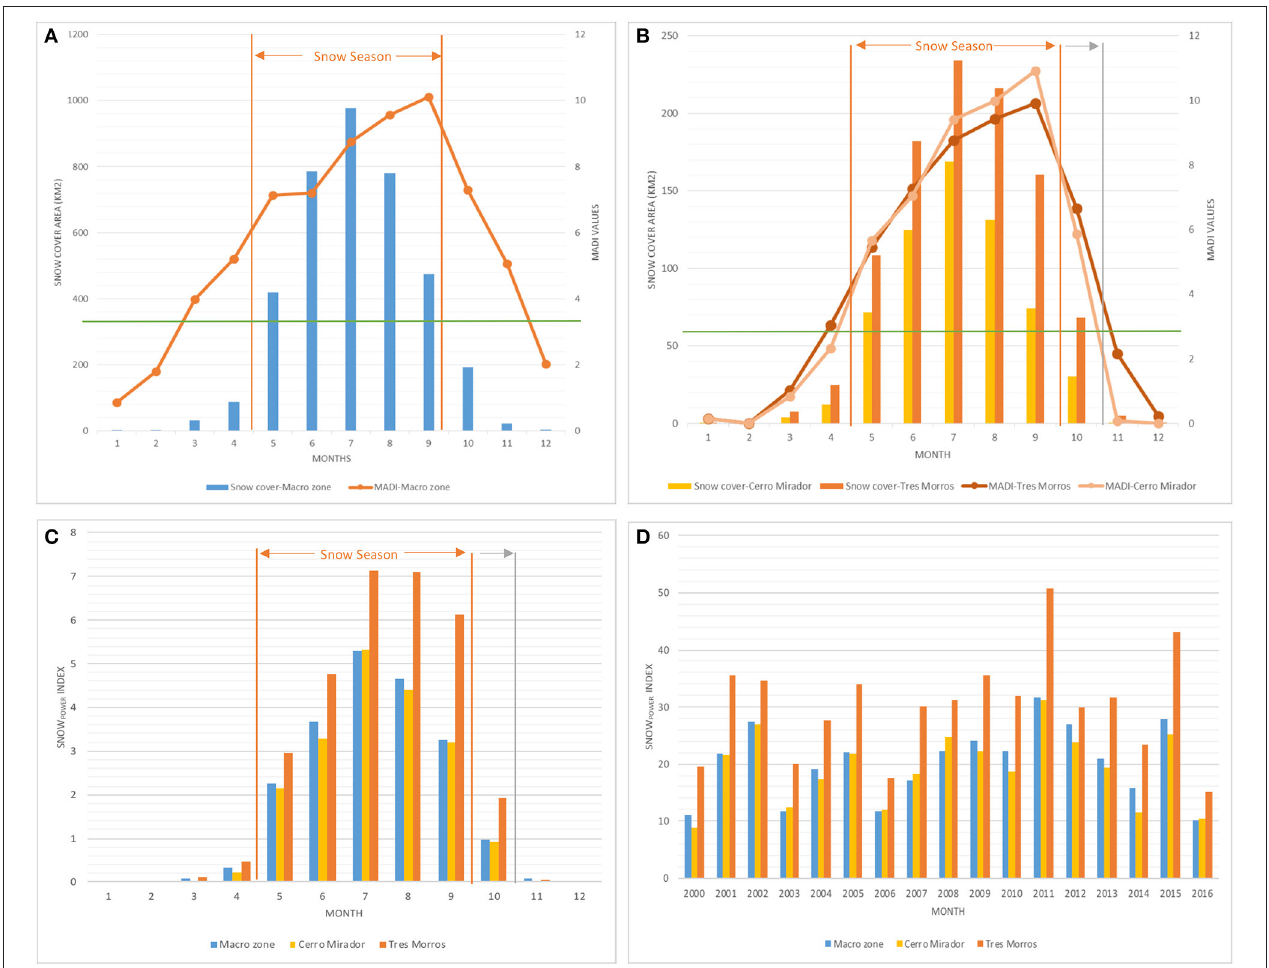
FIGURE 8 | Monthly average representation of the snow cover area and the Snow power index for 2000–2016. (A) shows the mean monthly snow cover area, the MADI index and the duration of the snow season in the Macro zone. (B) Represents the same snow properties for the sub-regions Cerro Mirador and Tres Morros. (C) Provides monthly averages of the Snow power index for the period 2000–2016, and (D) shows the monthly Snow power index sums for 2000–2016 for each zone. The green line on (A,B) represents 20% of the multi-year maximum monthly snow extent on each zone, which is used for inferring the beginning and the end of the snow season. The gray line on (B,C) represents the extent of the snow season on Tres Morros in comparison to Cerro